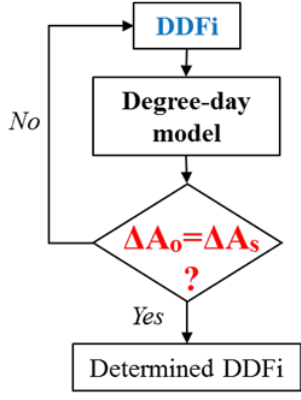
Figure 2. The calibration scheme.